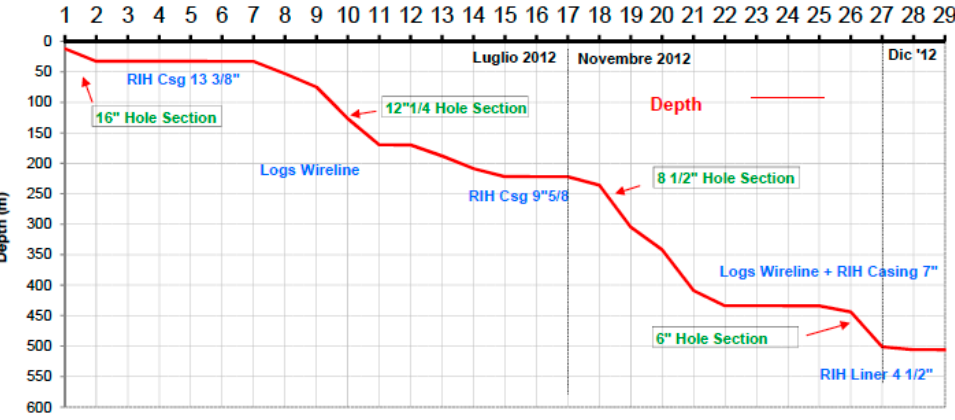
Figure 4. Well drilling diagram. Figure 4 . Well drilling diagram . Figure 4 . Well drilling diagram .